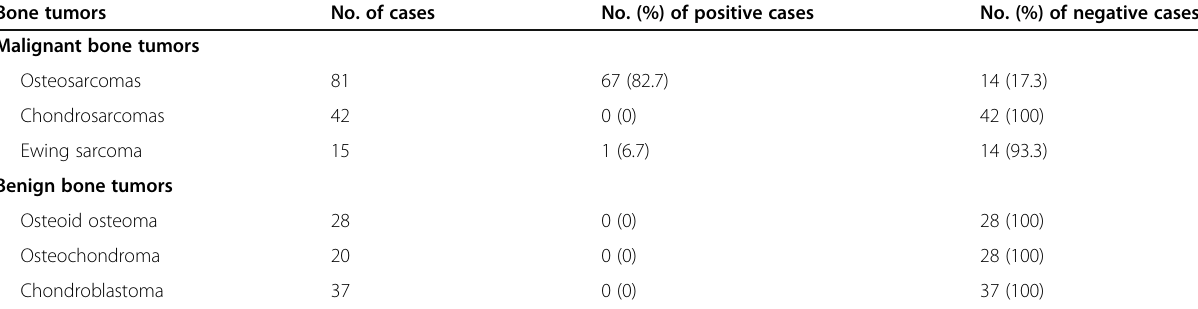
Table 2 Summary of immunohistochemical staining for KPNA2 in bone tumors Bone tumors